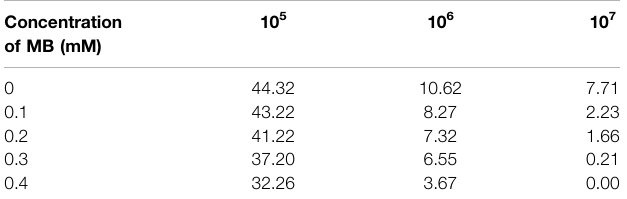
TABLE 2 | Plate colony count of E.coli ATCC 25922 was determined after the interaction of MB. Concentration of MB (mM)